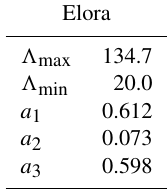
Table 1. Factory-fitting parameters for Eq. (5) were used for the Elora site. Values were obtained from the CRNS manufacturer and are representative of a terrestrial landscape.